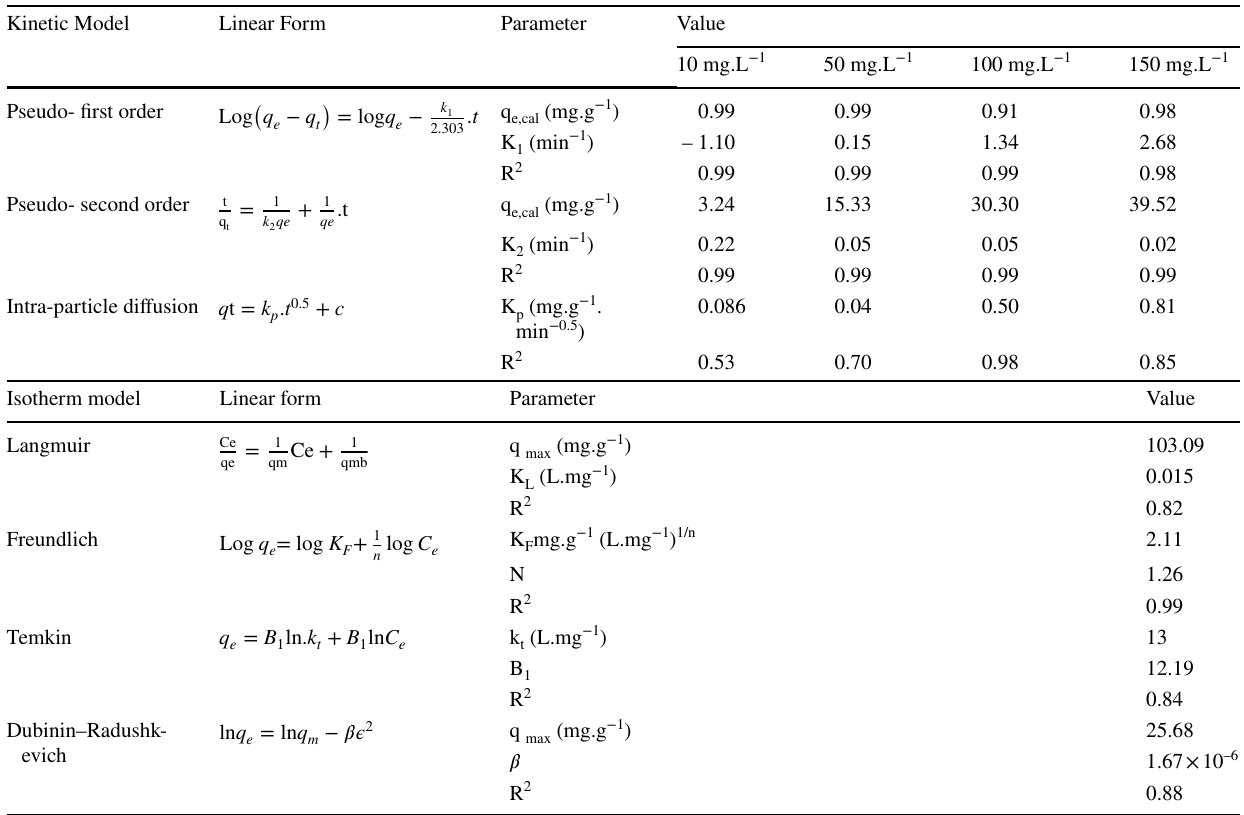
Table 6 The kinetic and isotherm parameters fitted for MG removal by S. platensis